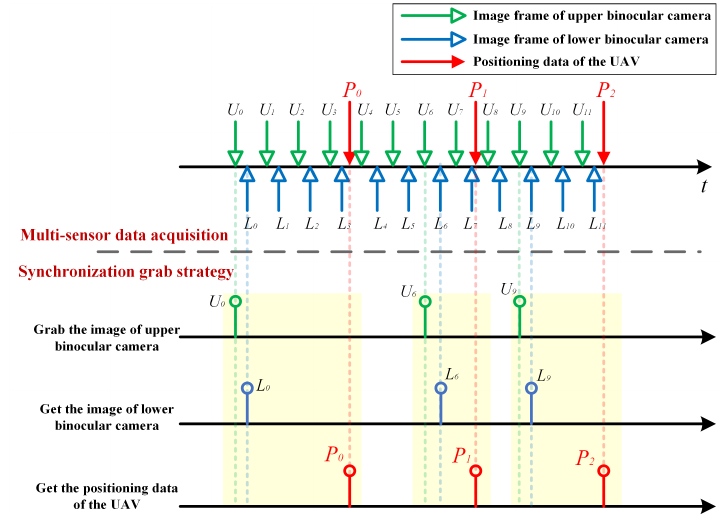
Figure 3. Schematic diagram of multisensor data synchronous capture